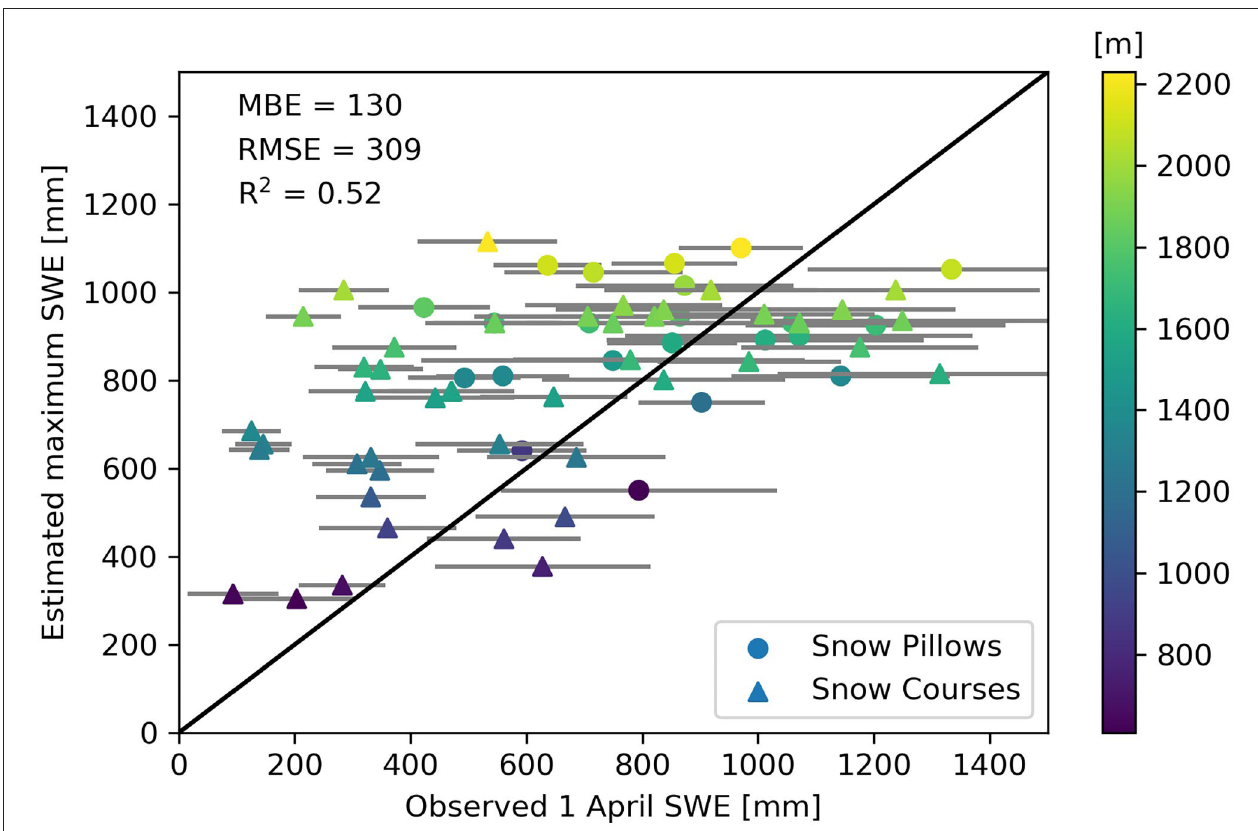
FIGURE 3 | Mean observed 1 April SWE ( ± standard deviation) for 18 snow pillow sites (circles) and 44 manual snow course sites (triangles) within the study region (see Figure 1 ), versus maximum SWE estimated from a simple linear accumulation gradient of 0.50 mm w.e. m − 1 . Points are color-coded by station elevation.